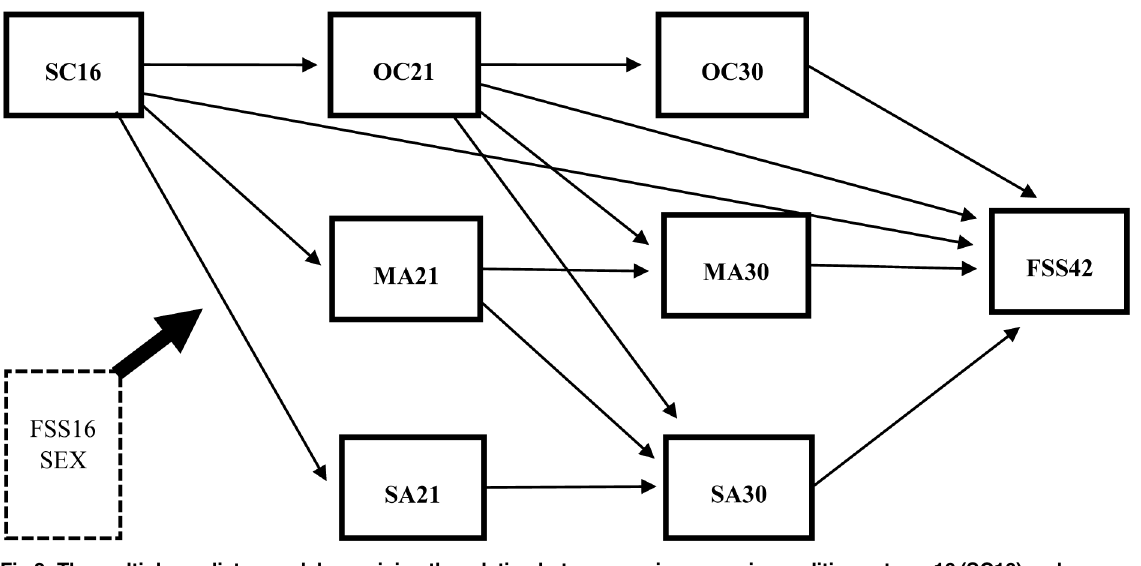
Fig 2. The multiple mediator model examining the relation between socioeconomic conditions at age 16 (SC16) and functional somatic symptoms at age 42 (FSS42), via occupational class (OC21 and OC30), material adversity (MA21 and MA30) and social adversity (SA21 and SA30) at age 21 and 30. Paths are estimated direct effects between the variables, while controlling for sex and the baseline functional somatic symptoms for the respondents at age 16 (FSS16) (n =